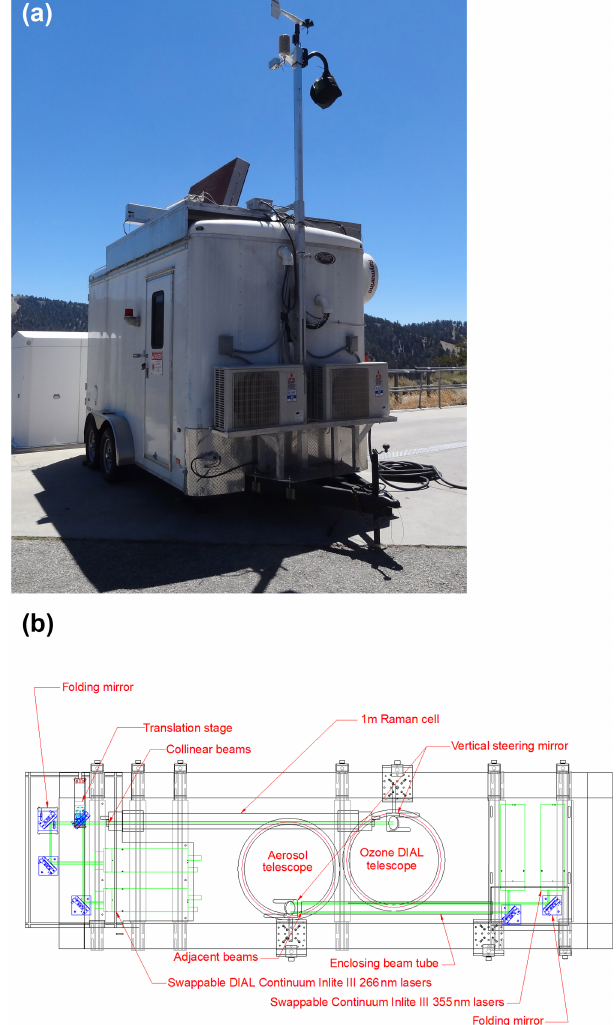
Figure 1. (a) A picture showing AMOLITE on location during the SCOOP campaign at Table Mountain in California. (b) A schematic diagram of the dual-laser, dual-lidar design of AMOLITE. Both li- dar systems are mounted on the same optical